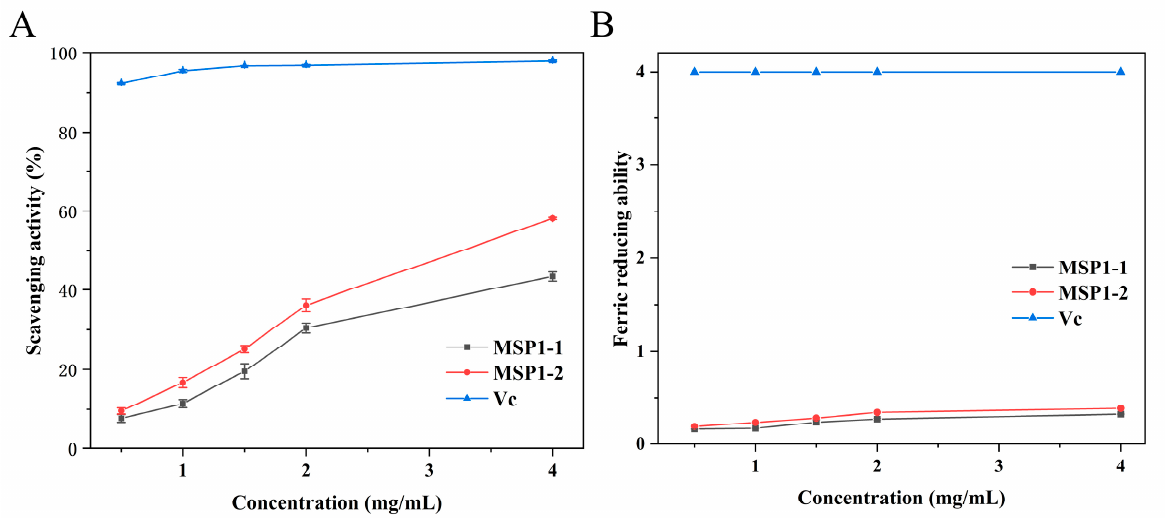
Figure 6. Antioxidant activity of MSP1-1 and MSP1-2. Scavenging activity on DPPH free radical ( A ), and ferric reducing ability ( B ).